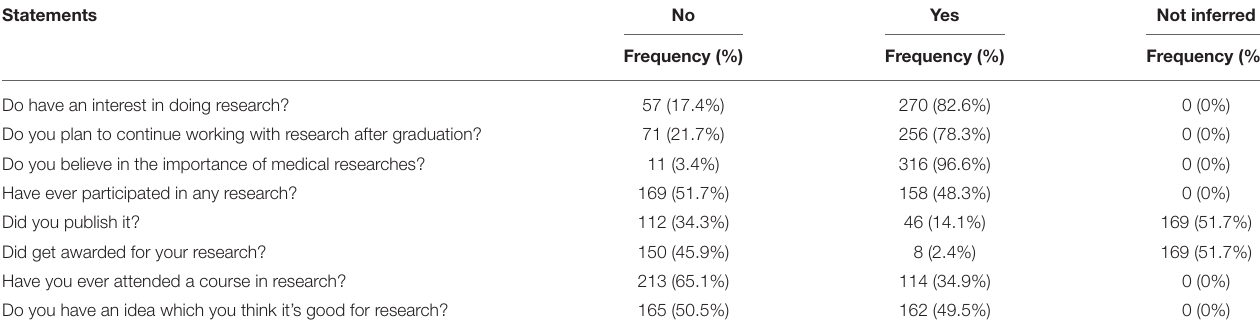
TABLE 4 | Attitudes of the students toward